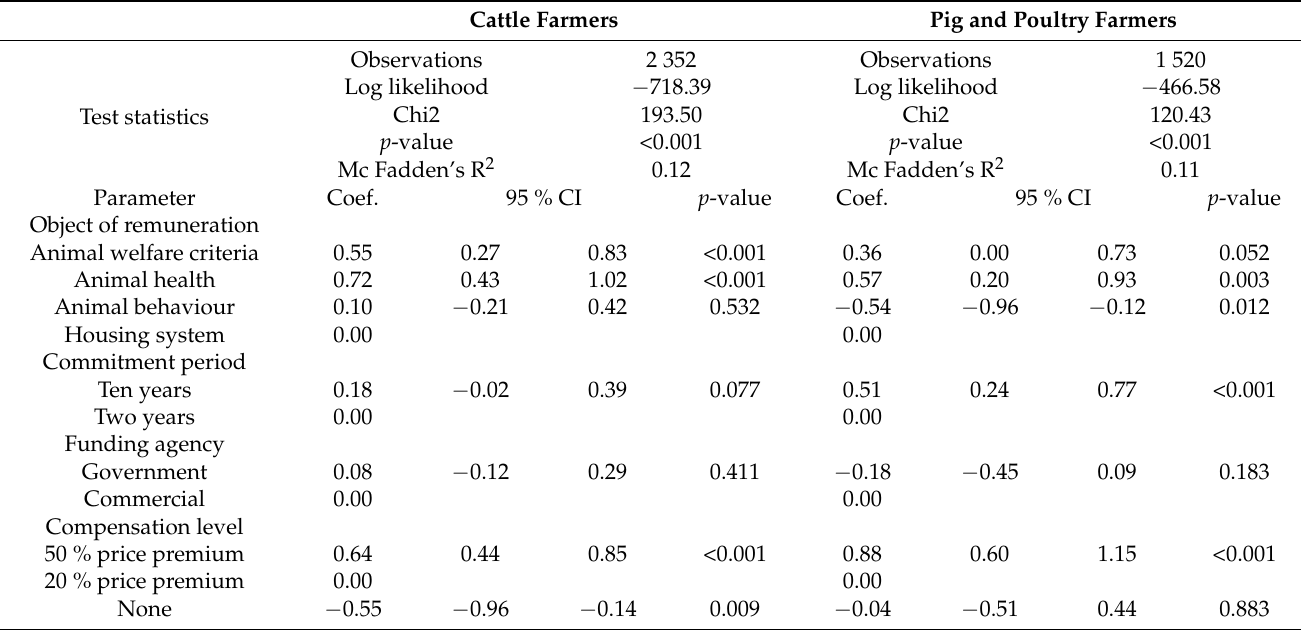
Table 3. Results of the conditional logistic regression models for cattle farmers and pig farmers. The coefficients (Coef.) represent the part-worth utilities of the individual